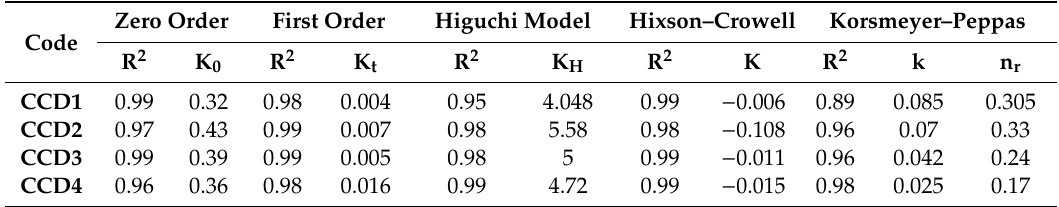
Table 5. The kinetic data obtained in the second stage of 8–96